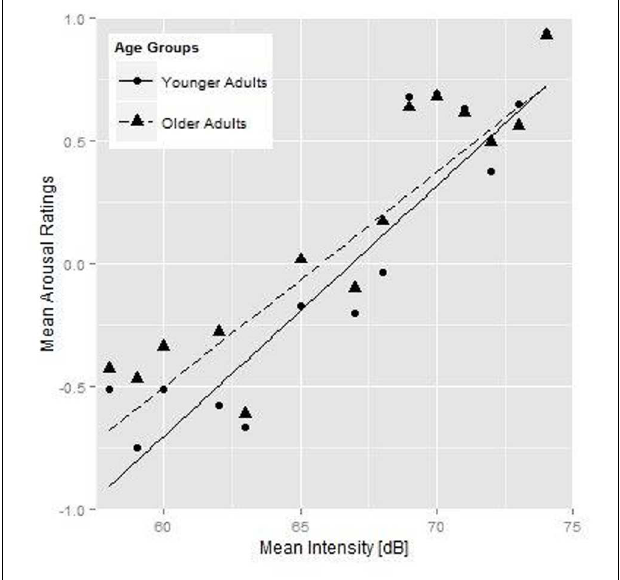
FIGURE 1 | Younger (round symbols) and older participants’ (triangular symbols) mean arousal ratings for each individual stimulus as a function of mean intensity of the speech fragments, and the fit lines for the younger (solid line) and older (dashed line)